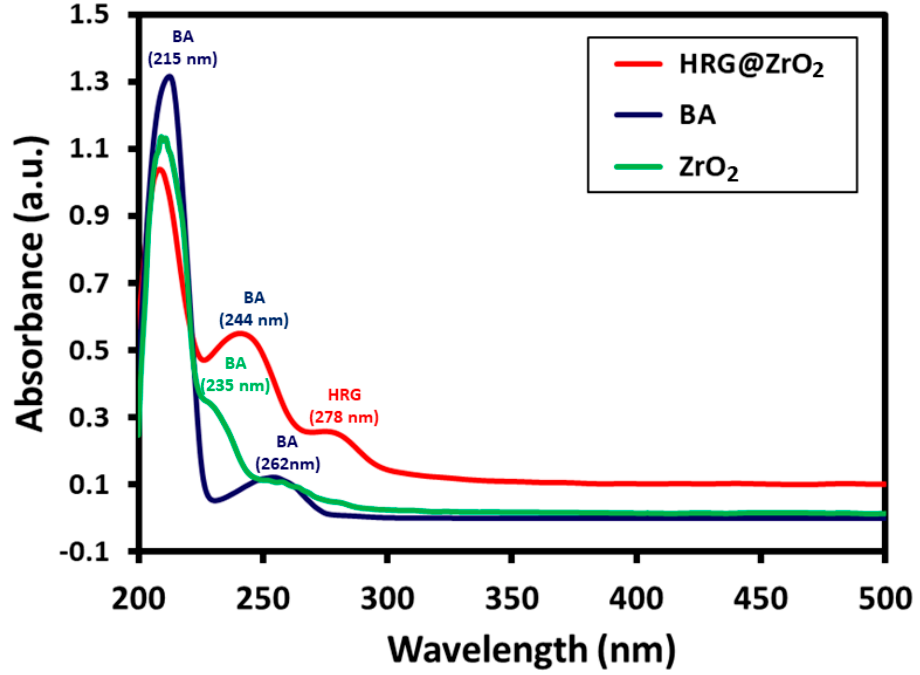
Figure 3. UV absorption spectra of ZrO 2 NPs (green line) and pure benzyl alcohol (benzyl alcohol, blue line) and HRG@ZrO 2 (red line). blue line) and HRG@ZrO 2 (red